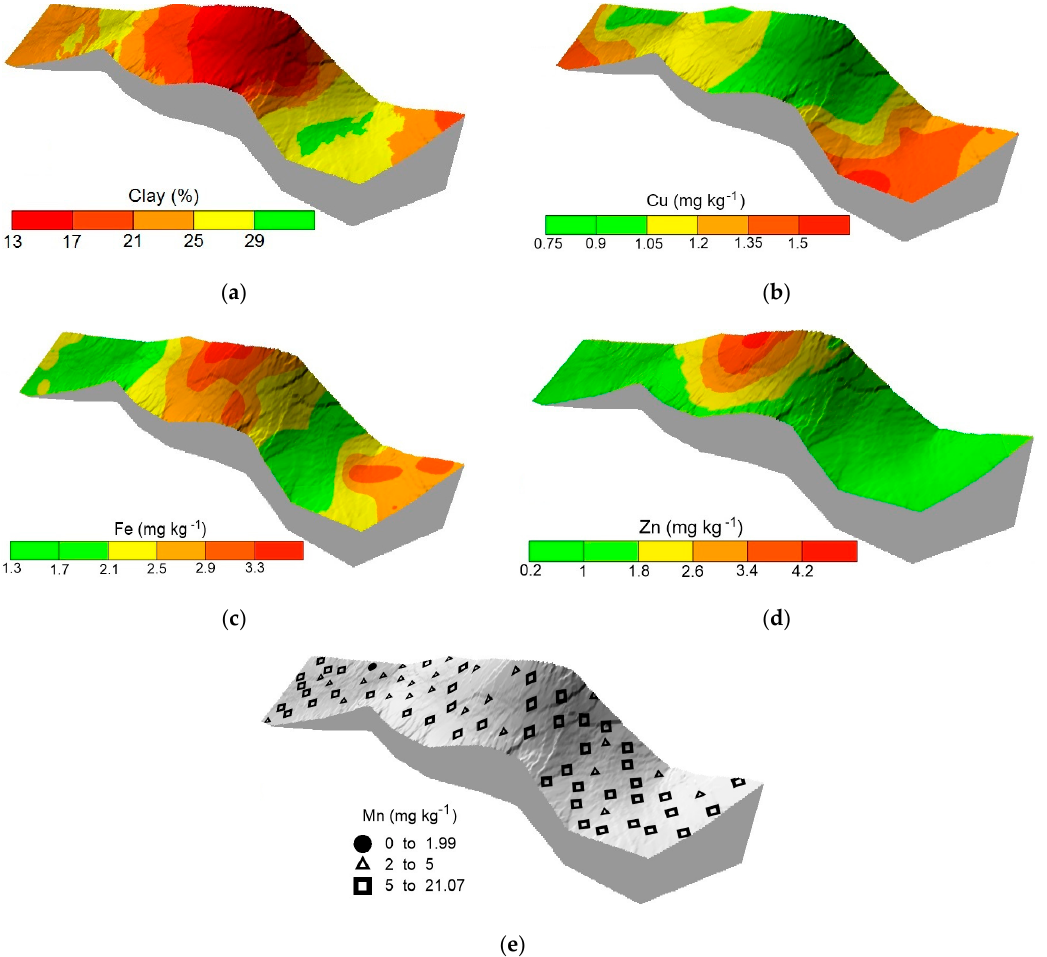
Figure 4. Thematic maps of clays ( a ), Cu ( b ), Fe ( c ), Zn ( d ) and Mn ( e ). The Mn did not present spatial dependence by the adjustment of variograms, in this way it is not possible to estimate values in non-sampled places, for this reason, the map was not made.